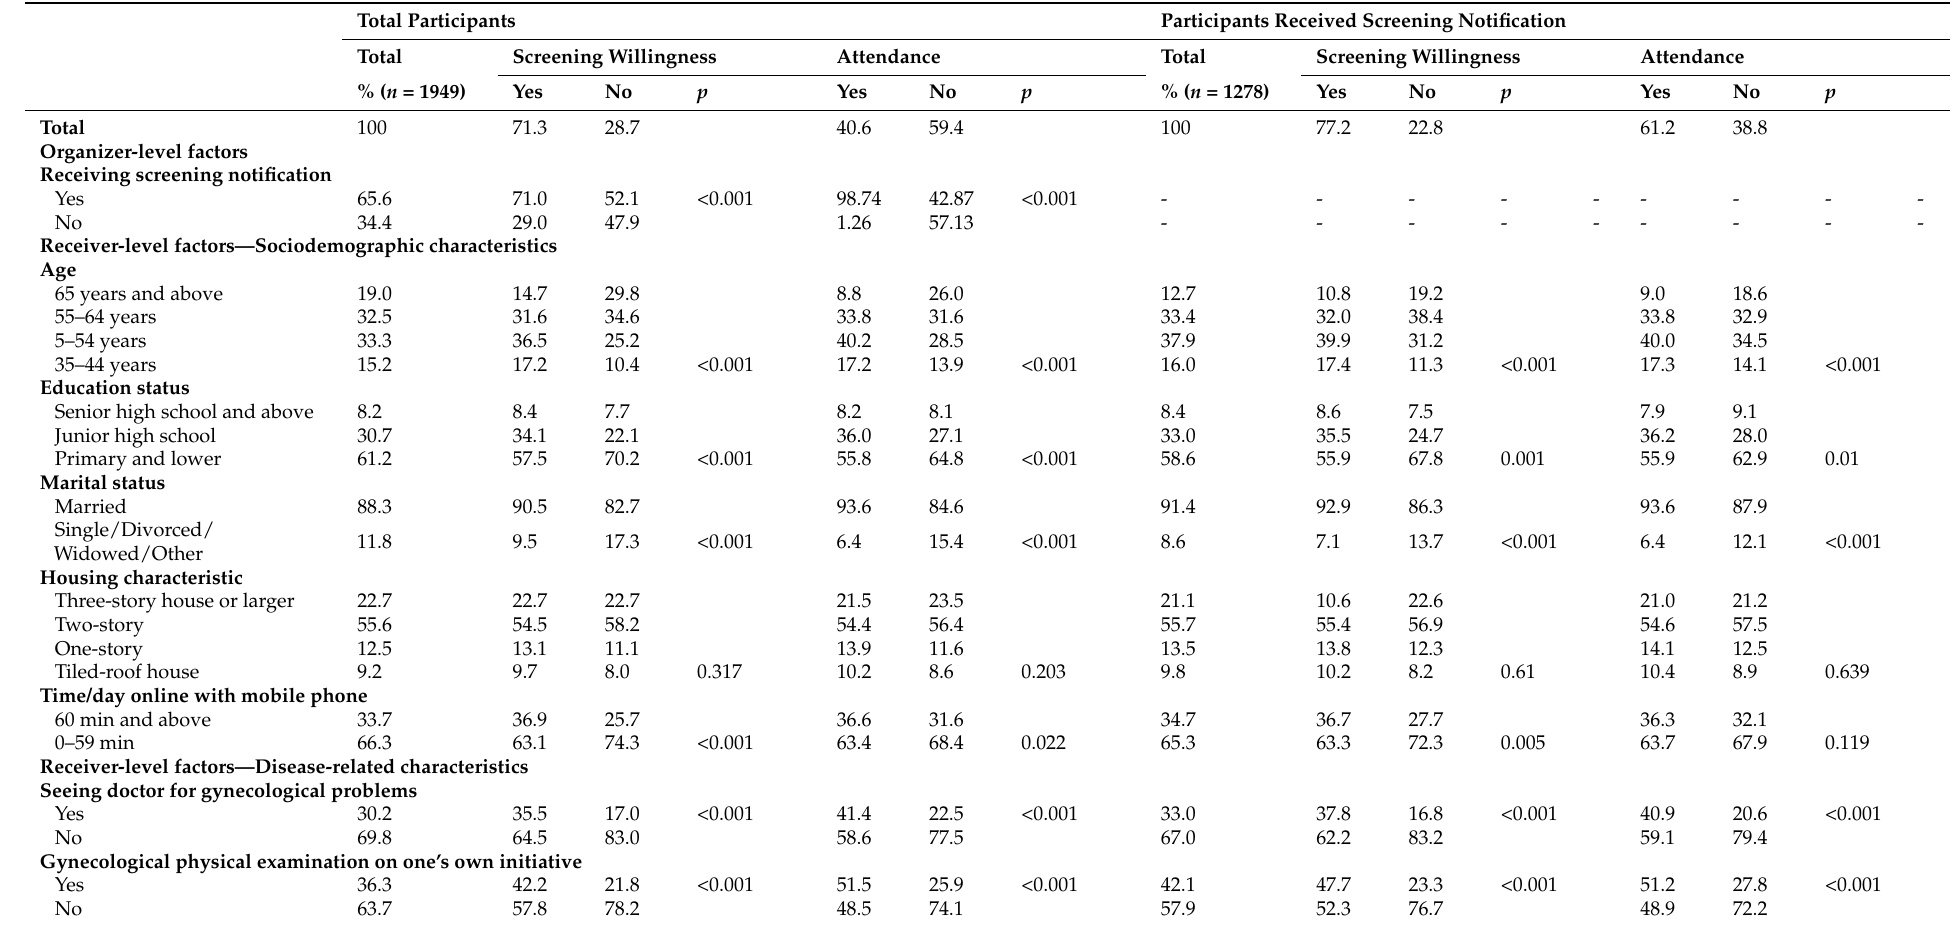
Table 1. General Characteristics of the Participants by Screening Willingness and Attendance of Cervical and Breast Cancer Screening